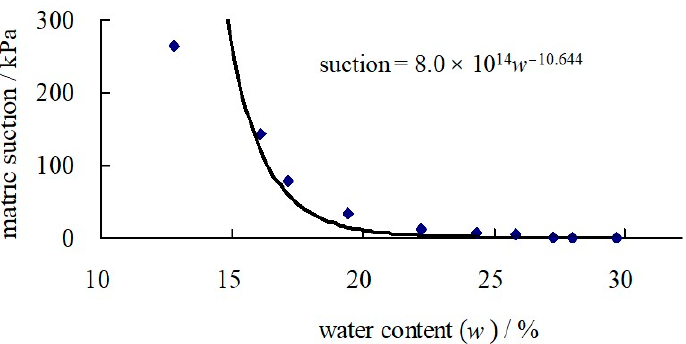
Figure 7. Characteristic curve of soil and water content.